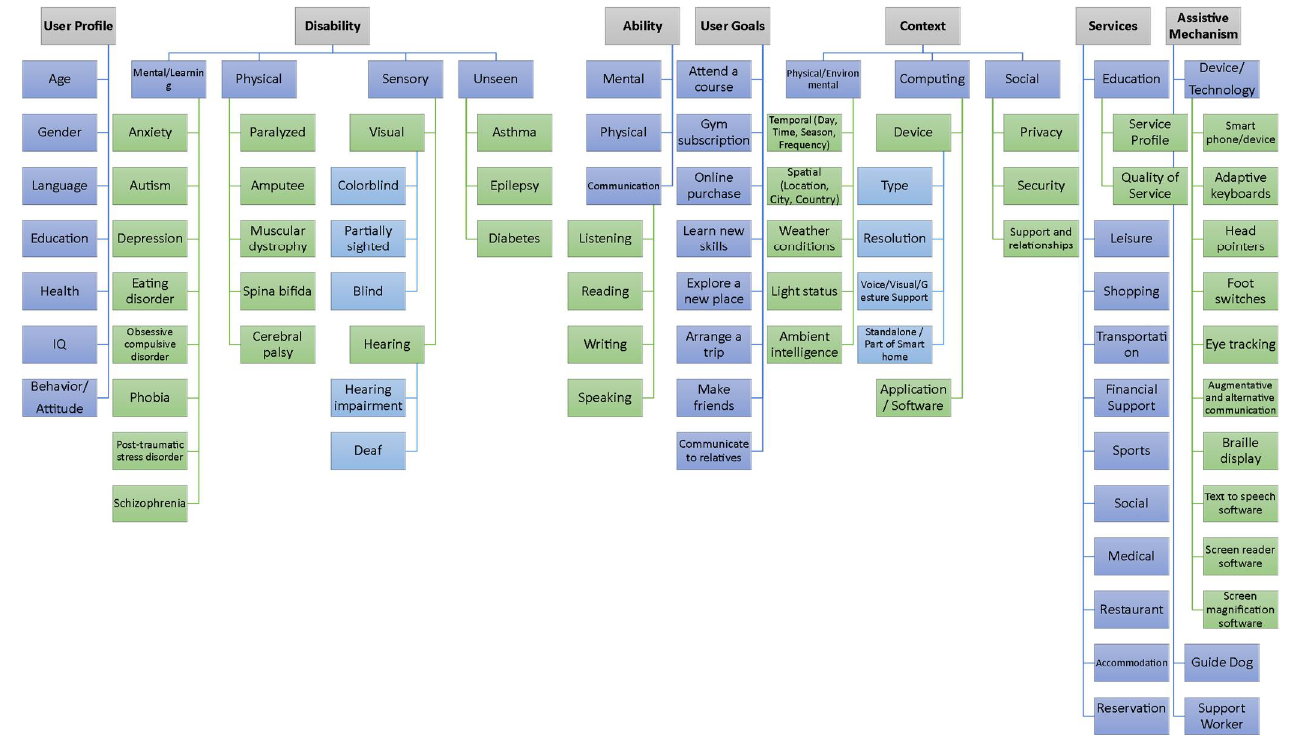
Figure 2. Our proposed disability ontology for enabling assistive service selection. The ontology includes seven main branches, namely user profile, disability types, abilities, user goals, content of use, services, and assistive mechanisms. Table 2. Summary of notable ontologies incorporating disability aspects and their domains of implementation.